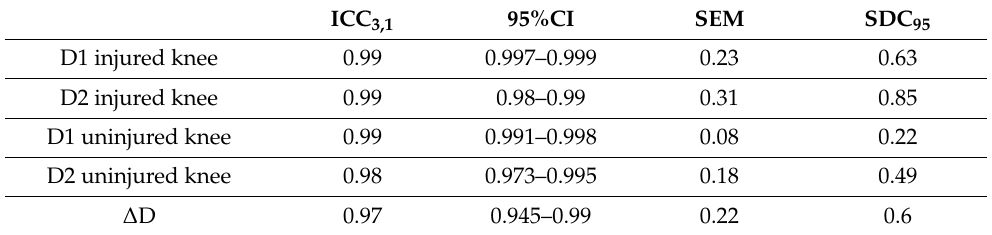
Table 2. The ICC 3,1 , SEM and SDC 95 values for D1, D2 measurements and ∆ D. ICC 3,1 95%CI SEM SDC 95 D1 injured knee